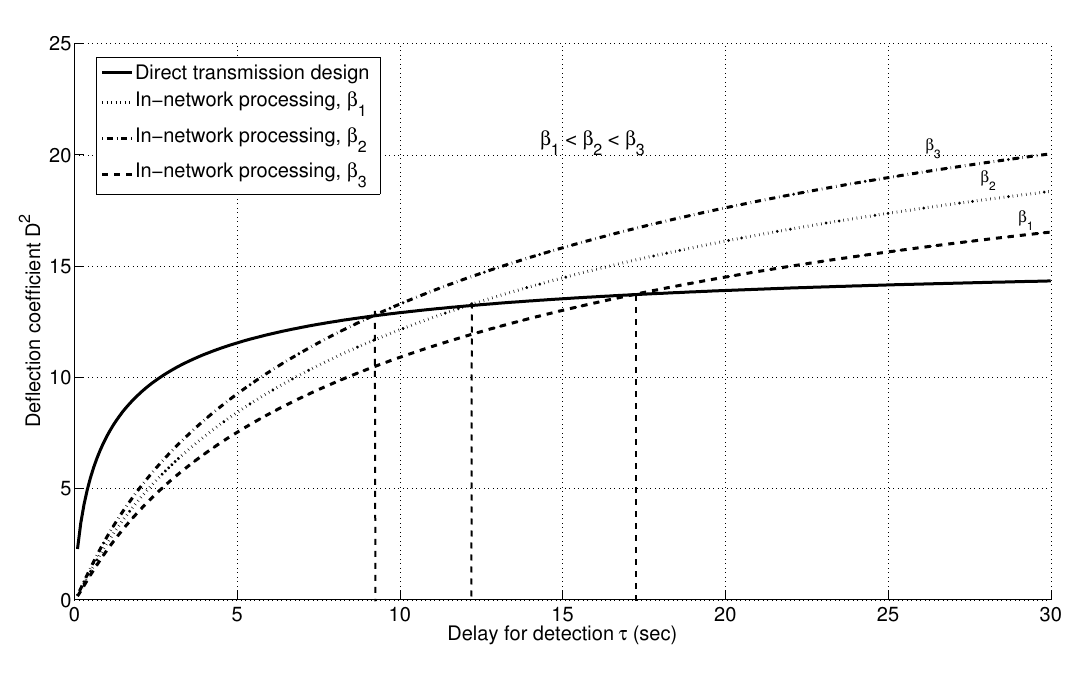
Figure 16. Variation of the detection threshold with quantizer design parameter β